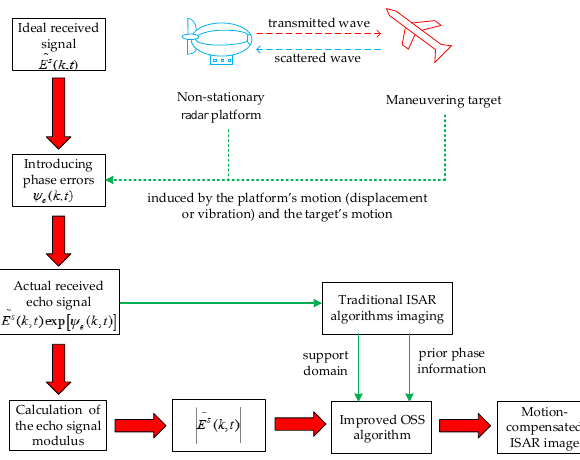
Figure 3. Block scheme of the proposed method.